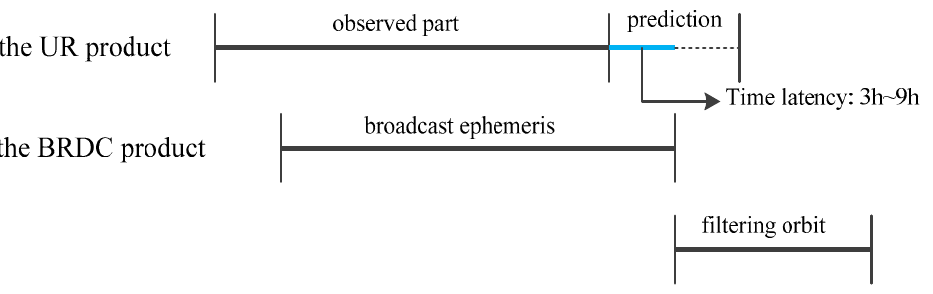
Figure 2. The initial orbit of SRIF filter orbit solution from the Ultra-Rapid products and the Broadcast Ephemerides.